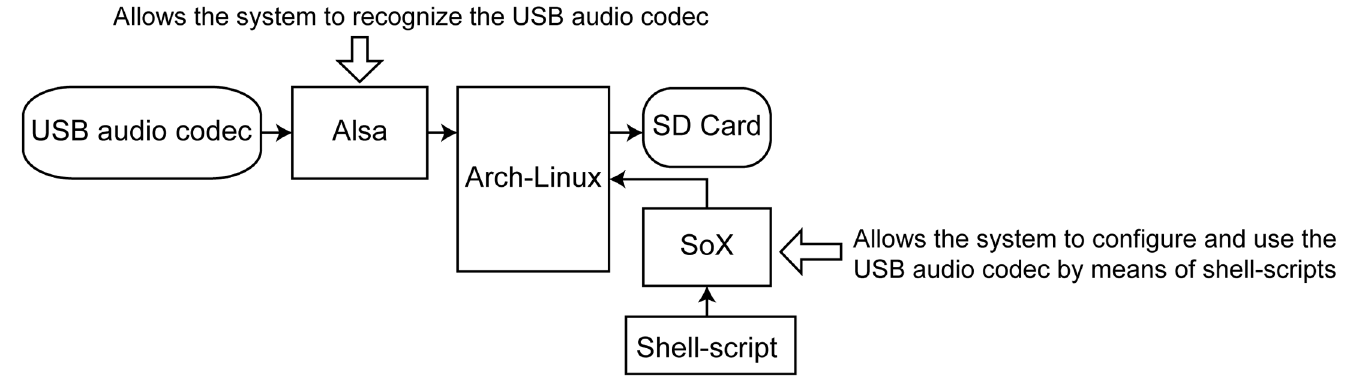
Fig 3. Schematic representation of the software/hardware interaction needed in order to capture the audio